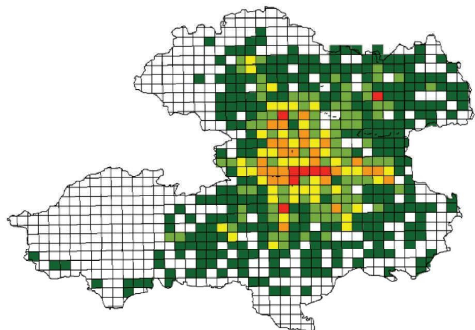
Figure 14: Distribution of shopping centers.